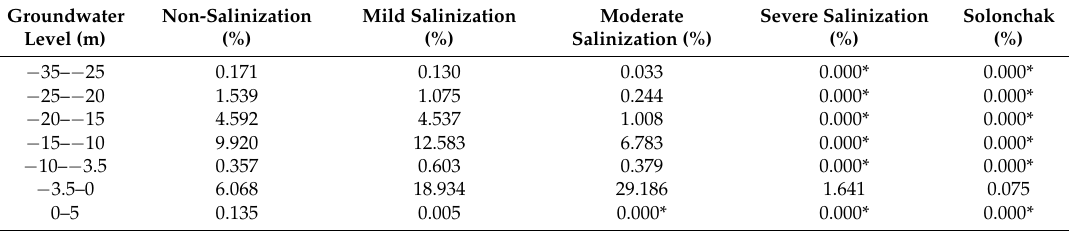
Table 7. Statistical Table of Groundwater Level and Salinized Soil in